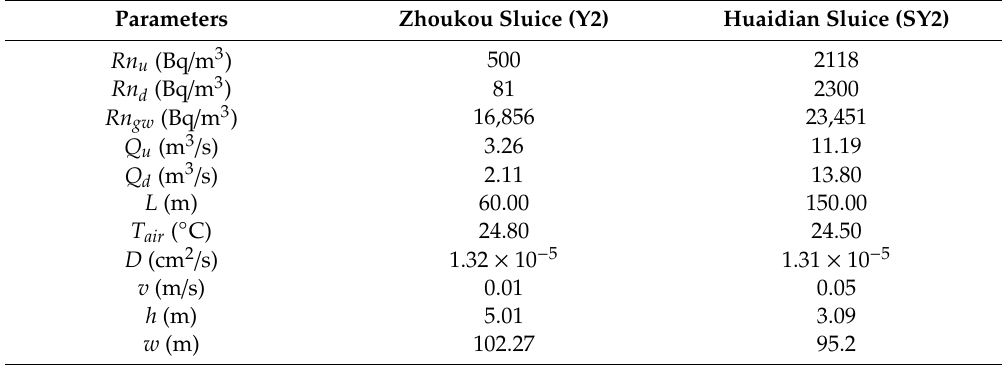
Table 2. The parameters of the estimated sections in the November 2019 sampling